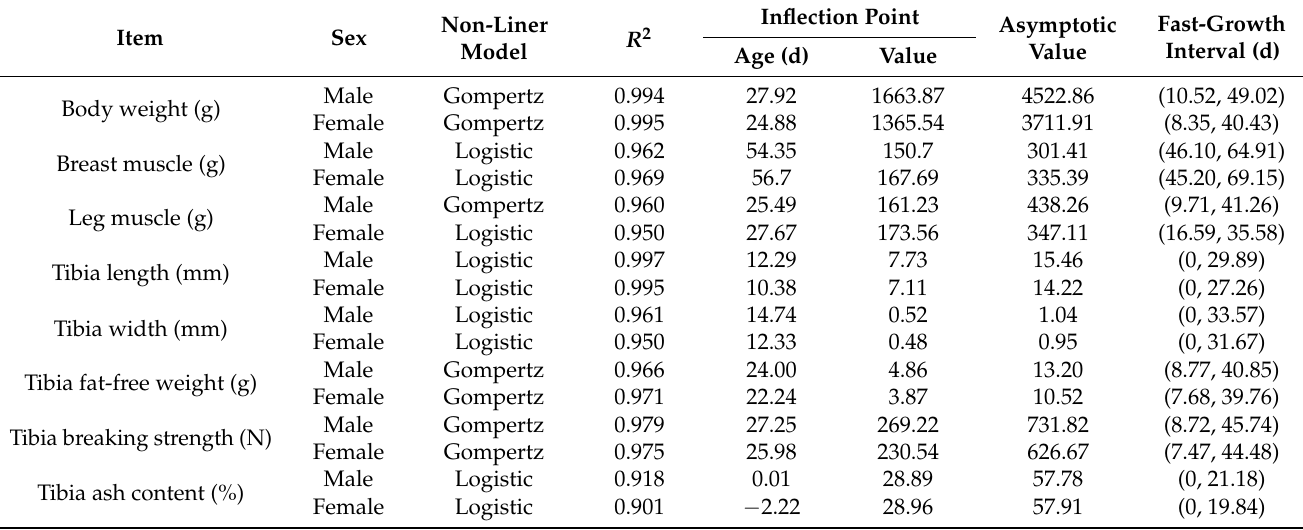
Table 3. Estimated values of body weight, muscle mass, and tibia traits using the non-linear model 1